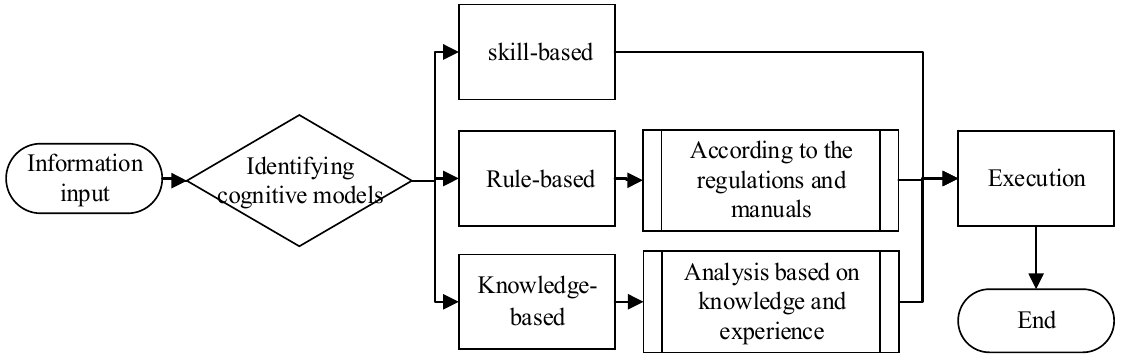
Figure 1. A flowchart of cognitive behavior.